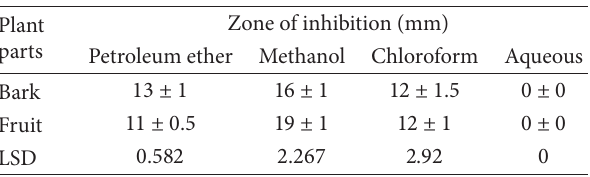
Table 3: Zone of inhibition produced by extracts of different parts of C. ambrosioides against E. coli .